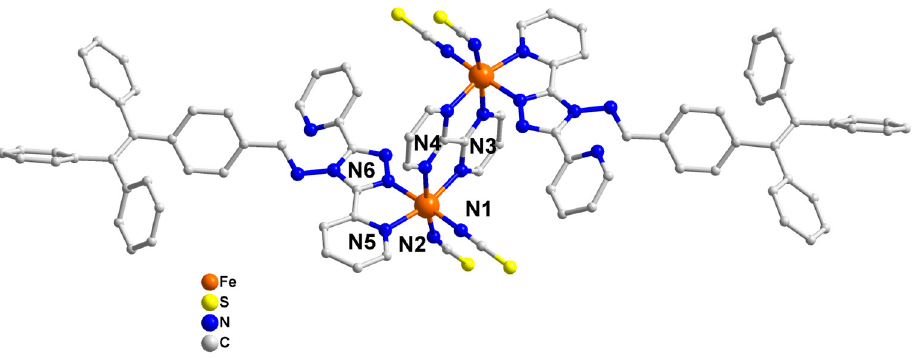
Figure 2. Molecular structure of {[Fe(abpt-TPE)(NCS) 2 ] 2 (bpym)}·2MeOH·2MeCN ( 1 ) at 100 K. Hy- drogen atoms and solvent molecules have been omitted for clarity.